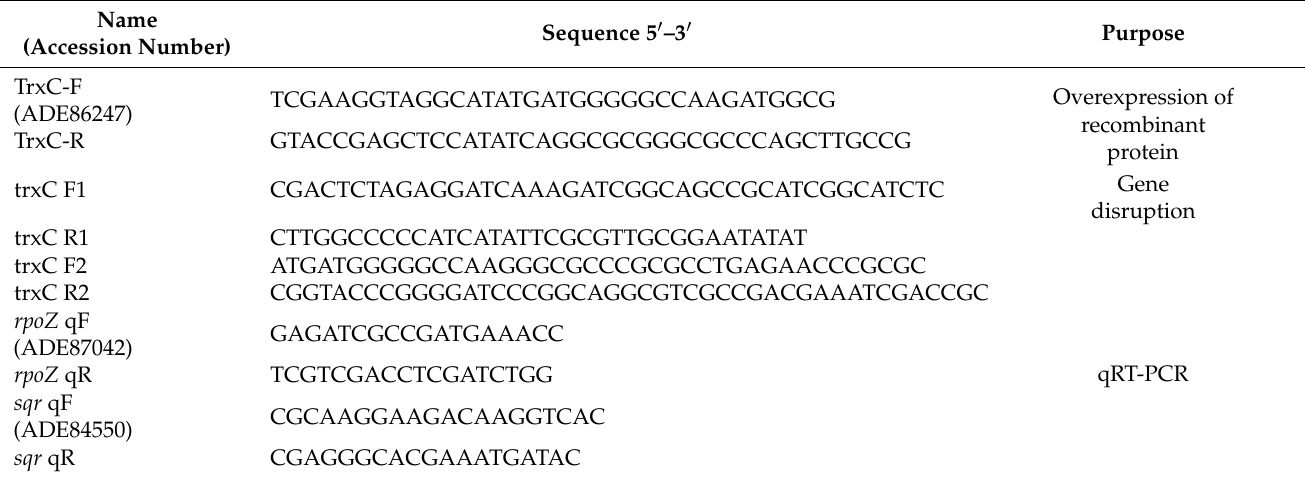
Table 1. List of primers used in this